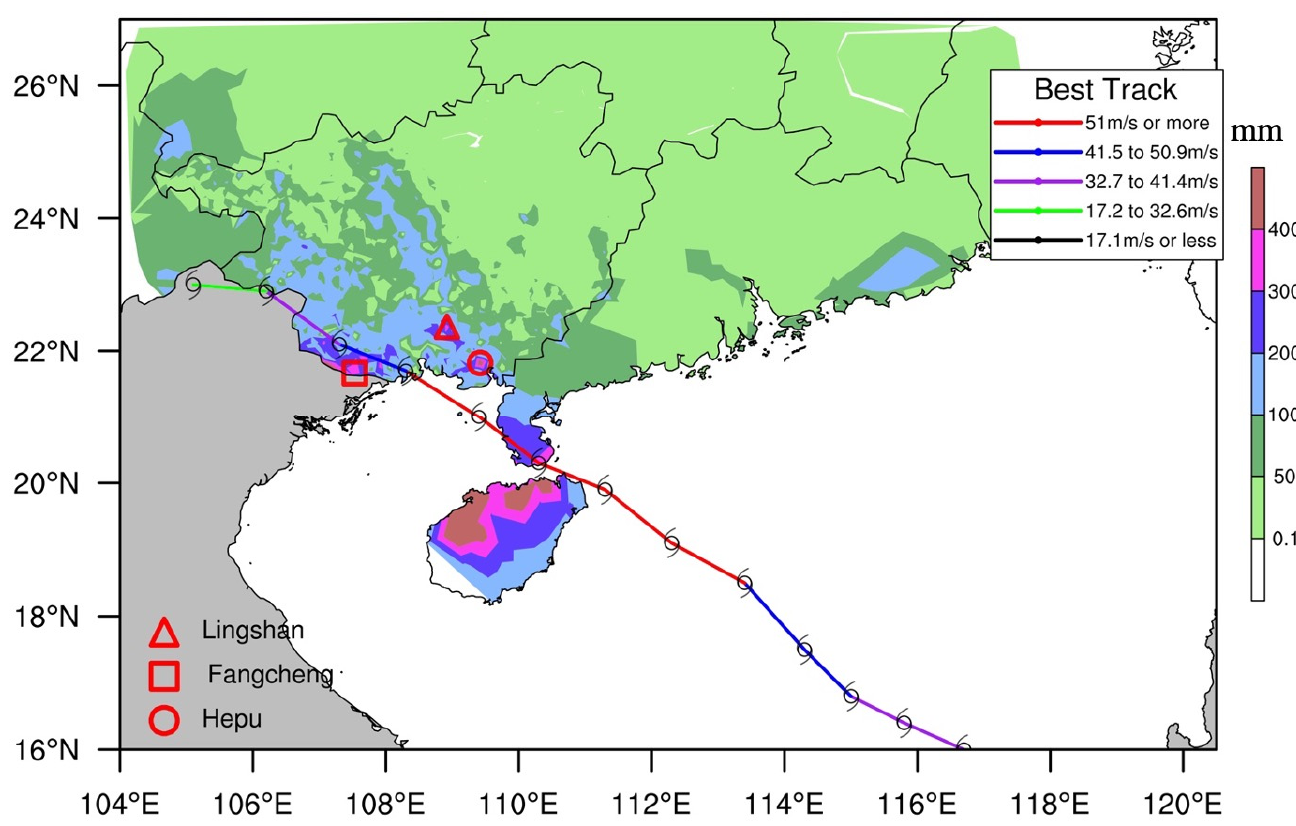
Figure 1. The accumulated precipitation (mm) from 20BST 17th to 20BST 20th July and the track and intensity changes of Rammasun, with the red markers denoting centers of three Guangxi rainstorms defined in Section 3.